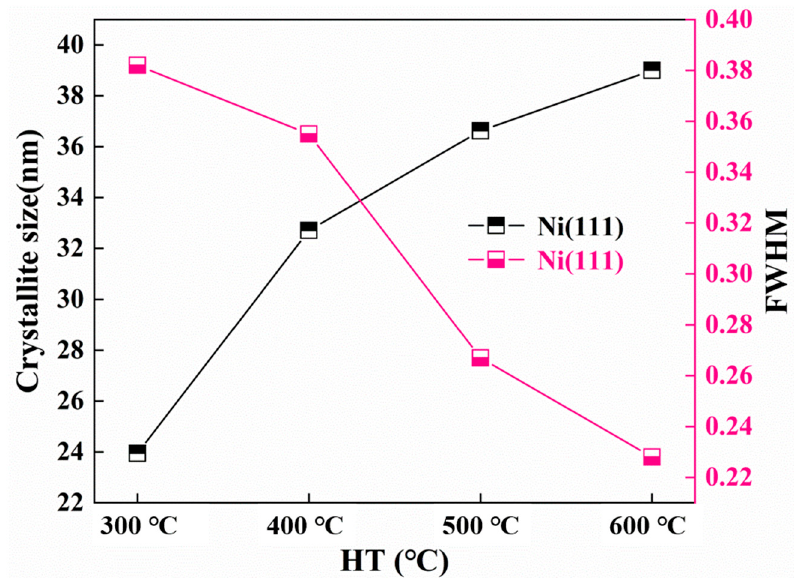
Figure 7. Crystallite size and the half-peak full width of Ni (111).